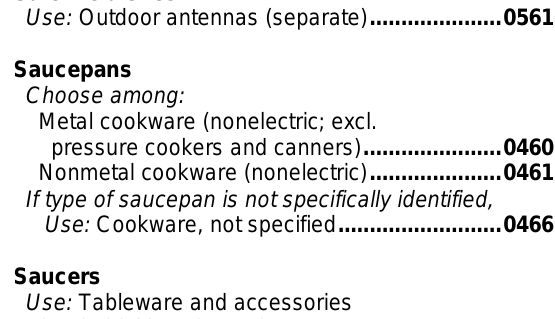
Salts, iron Code only for poisonings or chemical burns to children under 5 years of age Salt shakers or mills Use: Tableware and